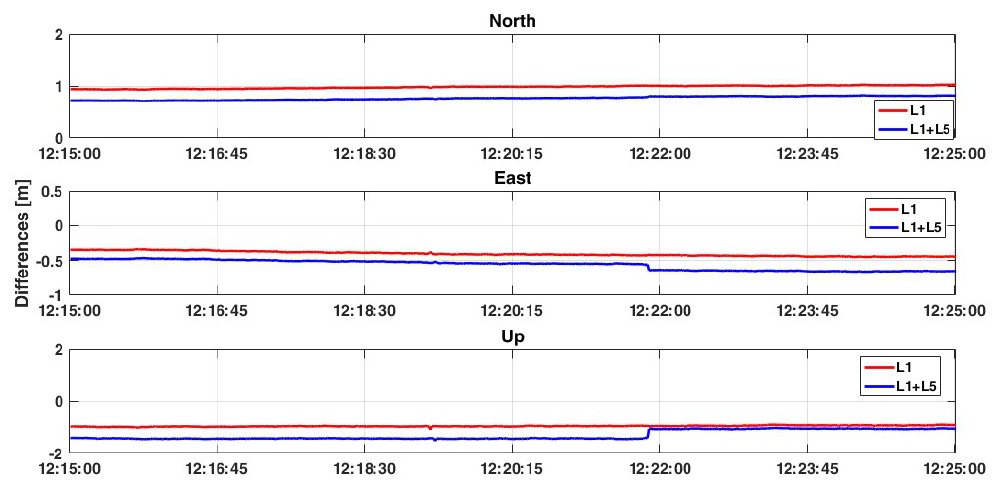
Figure 9. Comparison between L1 and L1 + L5 solutions considering GPS + GLONASS constellations with a ratio = 30. Table 9. Positioning results considering the GPS+GLONASS+Galileo constellations. L1+L5 frequencies are referred to only for GPS and Galileo constellations.